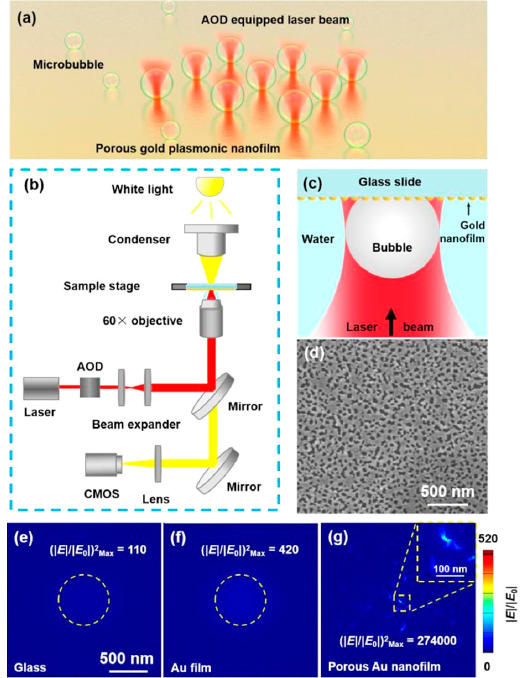
Figure 1. Working mechanism of the formation and manipulation of microbubbles on a porous Au nanofilm. ( a ) Illustration of the optical formation of a microbubble array. ( b ) Schematic of the experimental setup. ( c ) Schematic of bubble generation at the interface between water and the porous Au nanofilm. ( d ) SEM image of the surface geometry of the porous Au nanofilm. Simulated electrical field distributions on ( e ) glass, ( f ) a solid Au film, and ( g ) the porous Au film. The light intensity is in direct proportion to (|E|/|E 0 |) 2 .